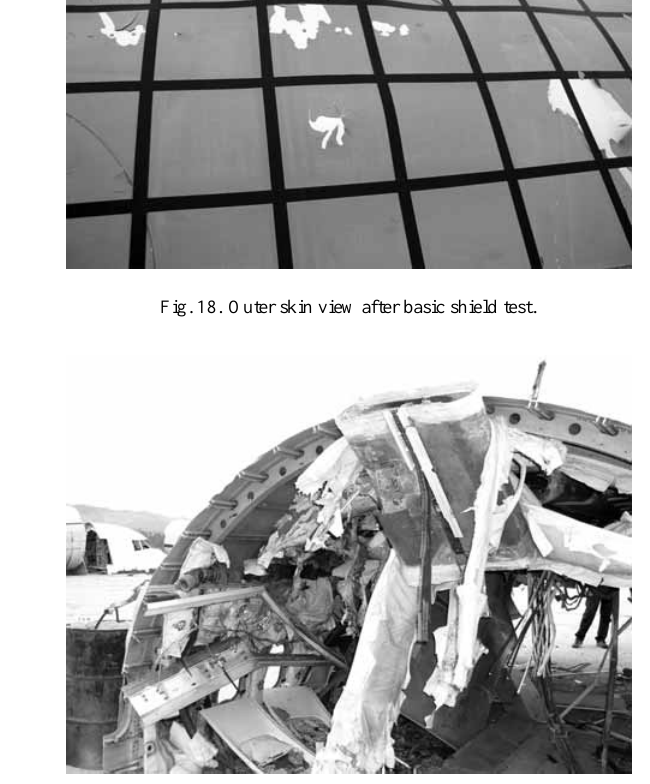
Fig. 19. Fuselage sectional view after basic shield